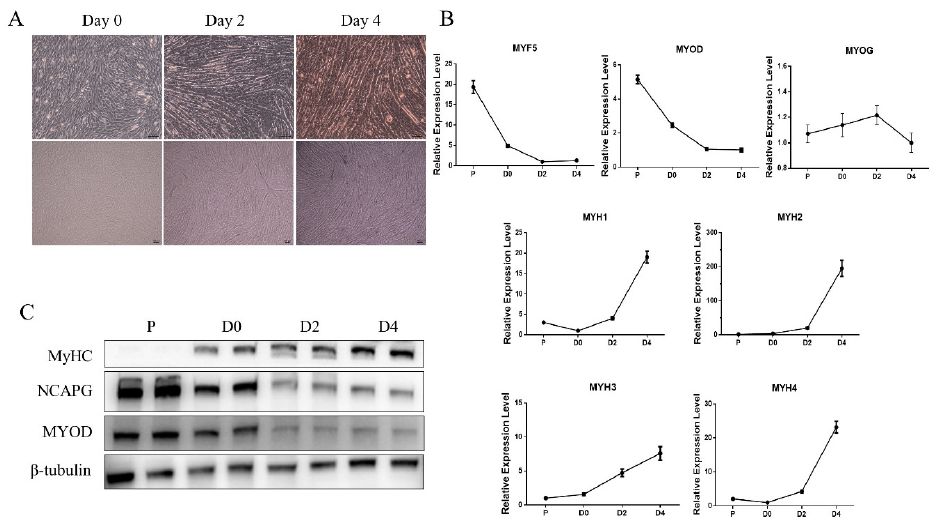
Figure 1. Myogenic di ff erentiation of myoblasts derived from fetal bovine tissue. ( A ) Microscopic images of bovine myoblasts on days 0, 2, and 4 of di ff erentiation. Scale bars = 100 µ m. ( B ) Transcript levels of MYF5, MYOD, MYOG, MYH1, MYH2, MYH3 and MYH4 during proliferation (P) and myogenic di ff erentiation (D0, D2, and D4). The results are represented as the mean ± the SEM from at least three independent experiments. ( C ) Western blot evaluating the protein levels of MYOD and MHCs in the cultured cells, as described in ( B ).